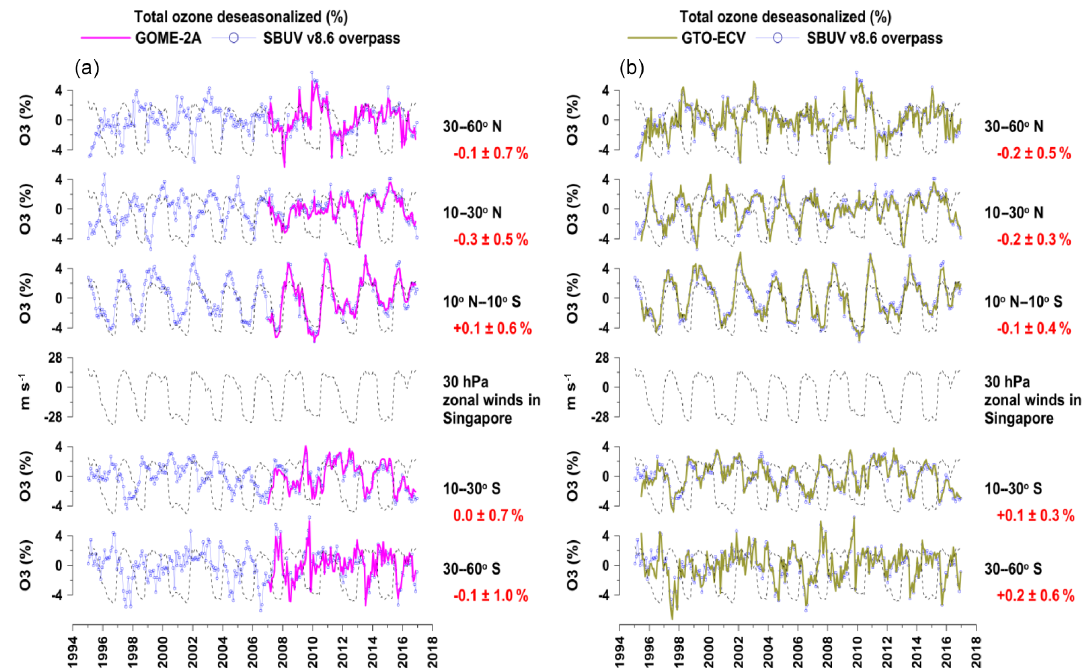
Figure 5. (a) Time series of deseasonalized total ozone from GOME-2A and SBUV (v8.6) satellite overpasses over different latitude zones, along with the equatorial zonal winds at 30hPa as an index of the QBO; (b) same as in (a) , but for GTO-ECV and SBUV. Values with red colour refer to the mean differences ± σ (in %) between GOME-2A and SBUV deseasonalized data averaged over various WOUDC stations (150 stations in the northern mid-latitudes – 30–60 ◦ N; 21 stations in the northern subtropics – 10–30 ◦ N; eight stations in the tropics – 10 ◦ S–10 ◦ N; 10 stations in southern subtropics – 10–30 ◦ S; and 12 stations in the southern mid-latitudes – 30–60 ◦ S). The QBO proxy is superimposed on the ozone